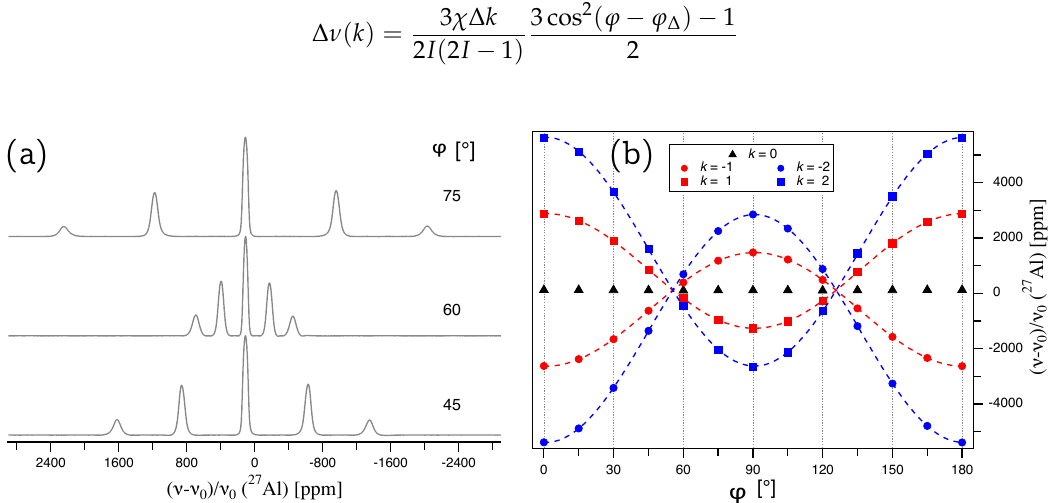
Figure 2. (a) 27 Al-NMR spectra of a single crystal of aluminium nitride, AlN, rotated counter-clockwise Figure 2. ( a ) 27 Al NMR spectra of a single crystal of aluminum nitride, AlN, with the indicated rotation by the indicated angle j around a rotation axis perpendicular to the external magnetic field ~ B 0 and angles ϕ referring to the full rotation pattern on the right. ( b ) Full rotation pattern over 180 o for 27 Al at situated in the crystallographic ab plane of AlN. (b) Full rotation pattern over 180 o for 27 Al at Wyckoff Wyckoff position 2 b , acquired by rotating the AlN crystal counterclockwise by 15 o around a rotation position 2 b , acquired by rotating the AlN crystal step-wise by 15 o around a rotation axis perpendicular axis which is perpendicular to the external magnetic field (cid:126) b 0 , and situated in the crystallographic ab to the external magnetic field ~ B 0 and situated in the crystallographic ab plane. The zero point of the plane of AlN. The zero point of the rotation, ϕ = 0, deviates by ϕ ∆ = 0.65 ◦ from the ideal position rotation, j = 0 , is defined by ~ B 0 being almost parallel to the [0001] direction, with the actual crystal where (cid:126) b 0 is parallel to the [000-1] direction (see text for details). orientation deviating by j D = 0.65  from it (see text for details).